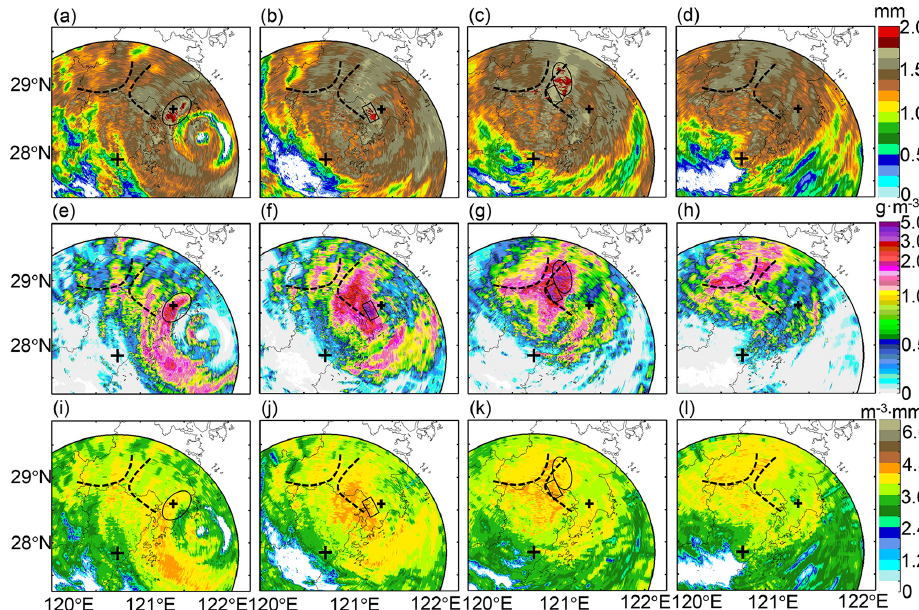
Figure 19. Radar-retrieved DSD parameters during typhoon Lekima: (a) – (d) are D 0 at 16:01, 17:59, 20:02, and 22:00UTC, 9 August 2019, respectively; (e) – (h) and (i) – (l) are LWC and log 10 ( N w ), respectively, at the same time as (a) – (d) . Two dashed lines refer to the GWS of YDM and KCM. The large + indicates the location of the WZ-SPOL radar site, and the little + indicates the location of the WL